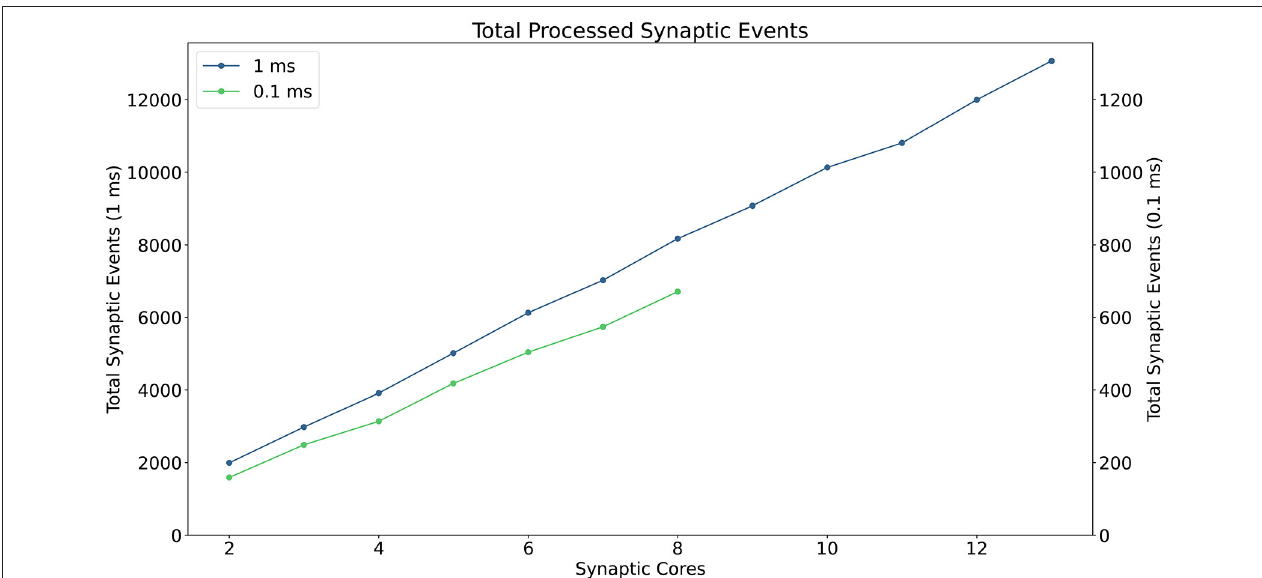
FIGURE 4 | Processed synaptic events per timestep at 10% connectivity with increasing Synapse cores per ensemble. The blue line shows the 1 ms case (values reported on the left axis), the green line the 0.1 ms case (values reported on the right axis). The number of Synapse cores is limited to 8 for the latter, because of timing constraints due to the synaptic contributions